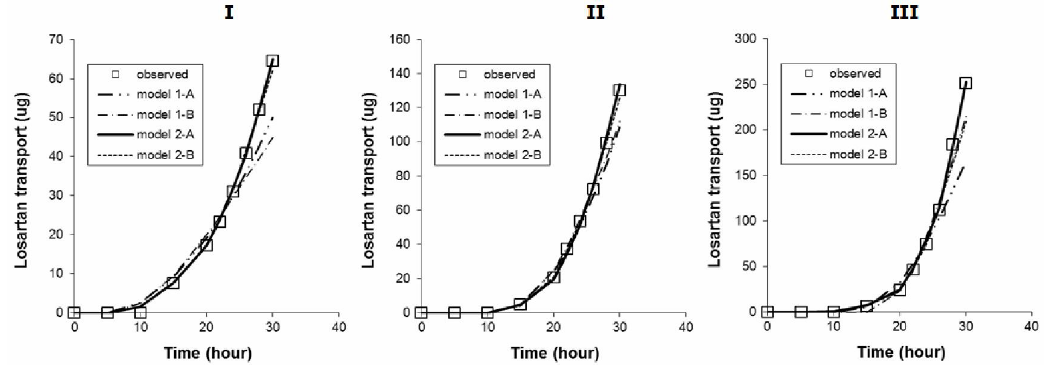
Figure 2. Observed data of transdermal transport of losartan of 3 samples in transport studies, presented together with the model prediction using model 1-A (-..-), model 1-B (-.-.), model 2-A (-- ) and model 2-B (- -